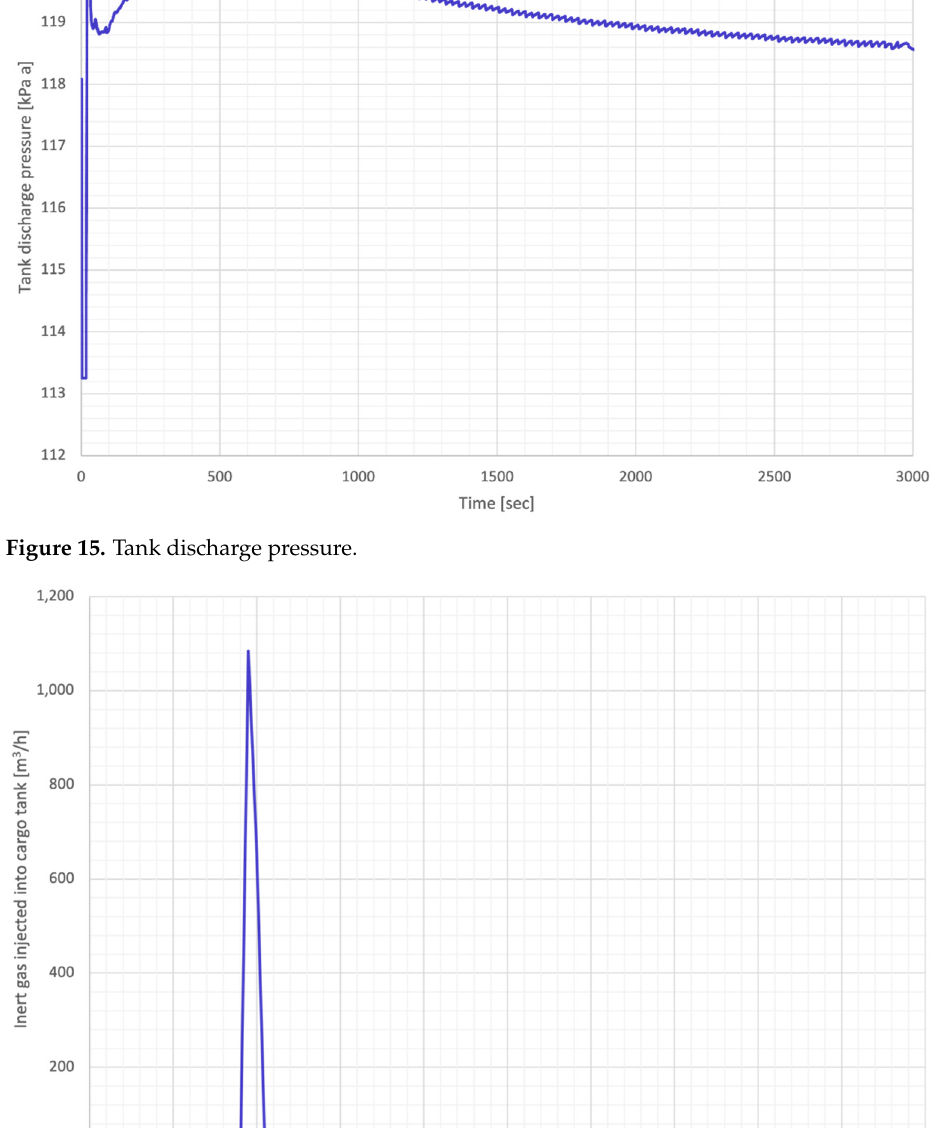
Figure 16. Inert gas flow rate injected into the cargo tanks.